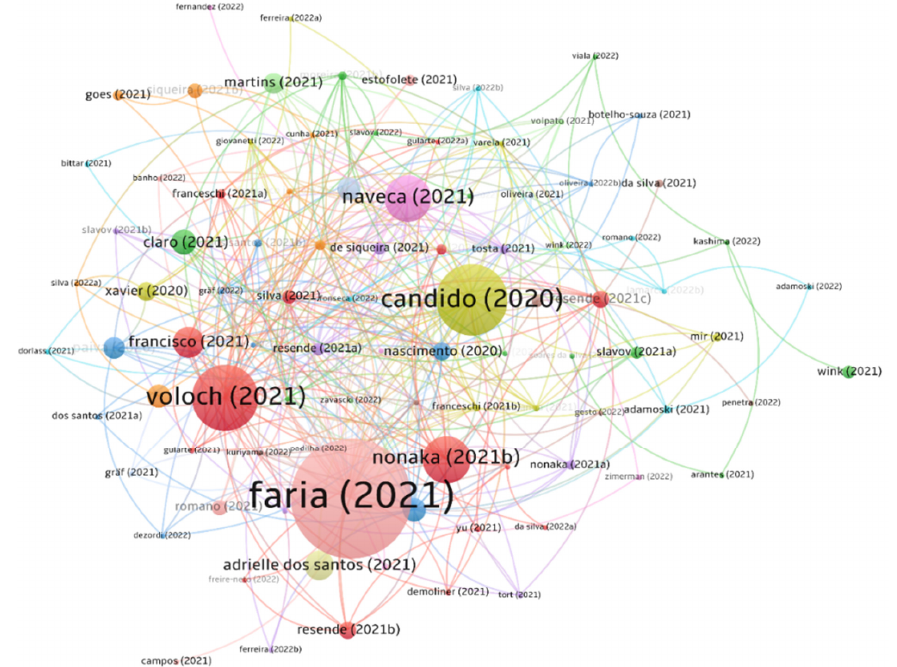
Figure 3. Citation map for articles cross-citations. Connectors indicate article citations. The circle size is weighted by the citation number of each study in the literature up to 25 October 2022. Thirteen clusters were found, and are indicated by different colours. Metadata is available in Table S5 [20– 25,27–42,44–54,56–61,63–70,72,72–81,83–91,93–102,104–112,114,116,118–123]. The second scientometric analysis showed authors who published together (Figure 4). The co-authorship network contains 127 authors in five clusters (Table S6). Five groups were also observed in the authors’ affiliation co-authorship network (Figure 5). We also created networks with keywords (Figure S4) and journals (Figure S5).